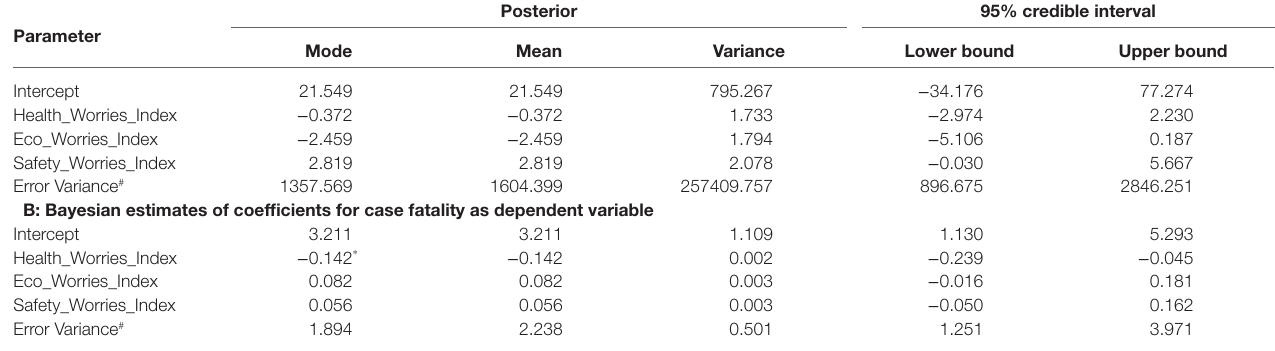
TABLE 5 | Bayesian